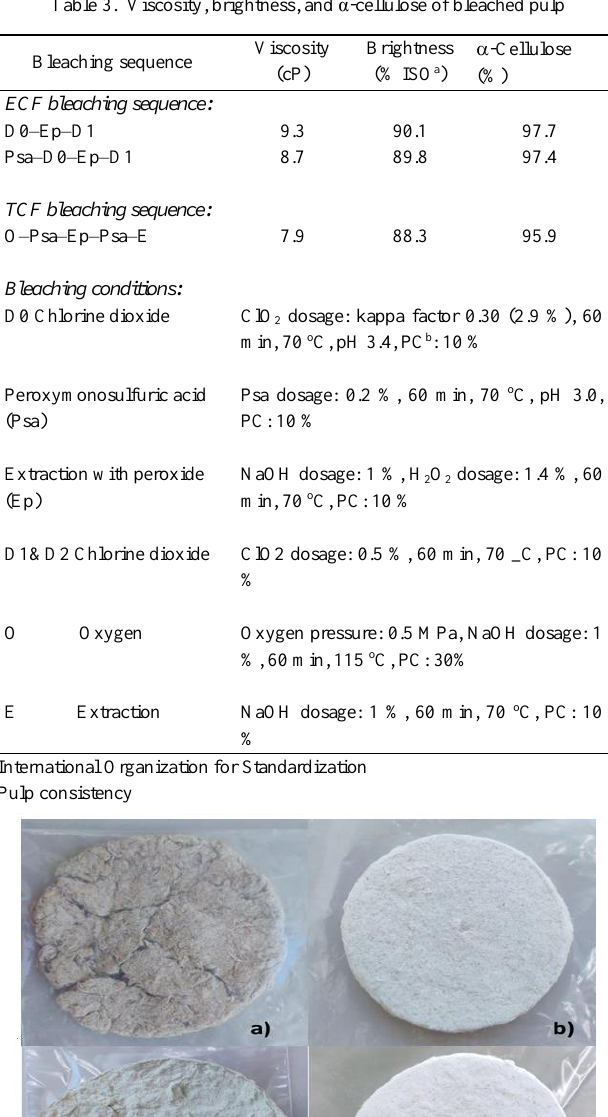
[29]. The ISO pulp brightness obtained was 88.5%.